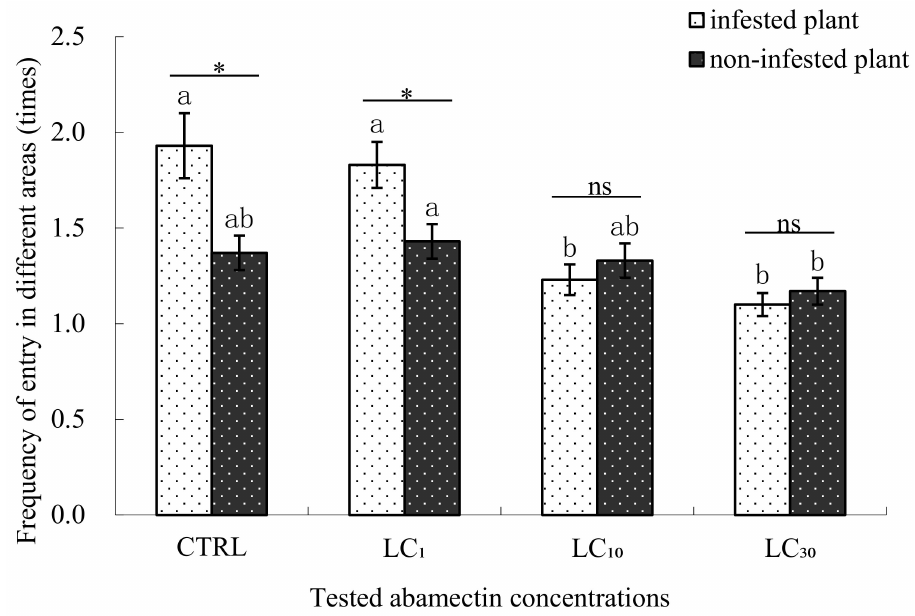
Figure 3. The frequency of Encarsia formosa entering different areas when treated with abamectin. Note: * p < 0.05 (significantly different between the two groups, t -test), ns (not significantly different between the two groups, t -test). The same letter over the bars of infested plant or non-infested plant areas indicates no significant differences between the various concentrations (Duncan’s multiple range test, α < 0.05). The “infested plant area” means cotton plants in the four-armed olfactometer infested with 3rd or 4th instar B. tabaci nymphs, while the “non-infested plants” means healthy cotton plants without whitefly infestation in the four-armed